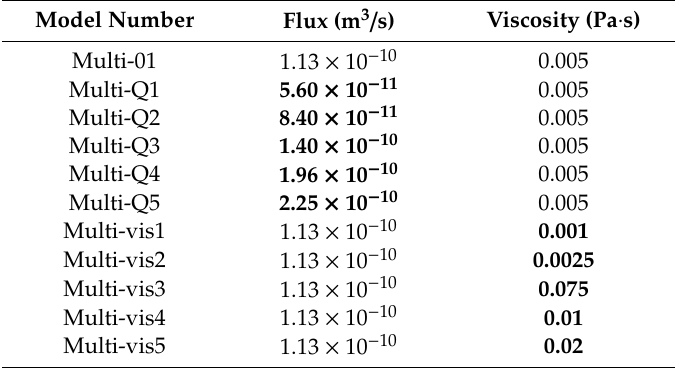
Figure 15. The configuration of the multilayered numerical models for investigation the sensitivity of fluid properties: the slices at x = 0.181 m, y = 0.2 m, and z = 0.132 m of the model. Table 5. The flux and viscosity of the fracturing fluid in multilayered laboratory-scale models. Model